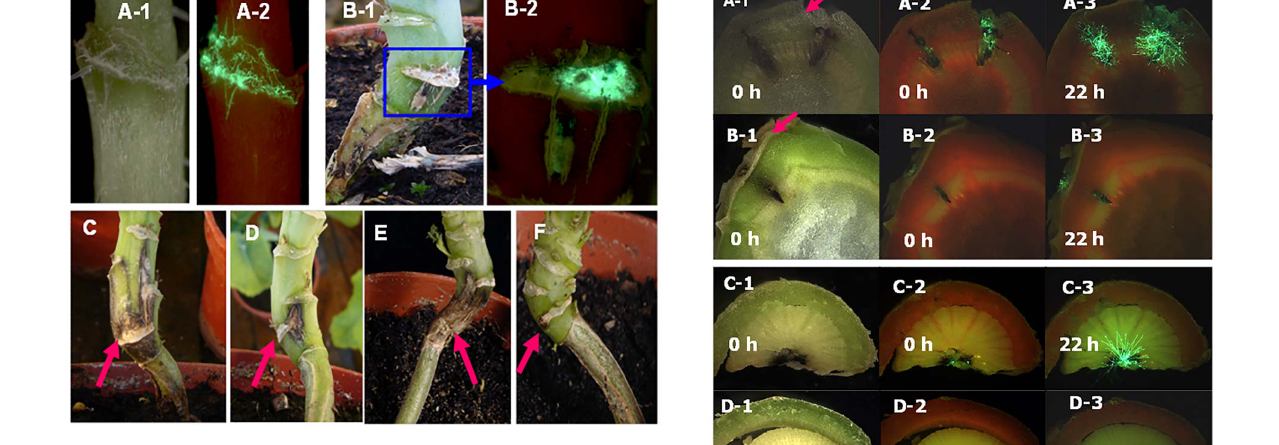
Figure 6. Phoma stem canker symptoms produced in con- trolled conditions. Leaf petioles of oilseed rape doubled haploid lines A30 (susceptible) or C119 (with quantitative resistance) were inoculated with conidia of GFP-expressing Leptosphaeria maculans isolate ME24/ 3.13 (A, B, C) or ascospores produced on stem debris under natural conditions (E, F). No visible stem canker symptom at the leaf scar (A-1) of A30 after the inoculated leaf had abscised at 25 days post inoculation (dpi) but growth of the pathogen was observed using a GFP2 filter (A-2). Stem canker was visible at the leaf scar of A30 at 36 dpi (B-1) and growth of L. maculans was visualised by GFP fluorescence (B-2) (the selected region in B-1 was viewed using a GFP2 filter). Symptoms at leaf scars of A30 (C, E) or C119 (D, F) at 87 dpi with conidia (C, D) or at 31 dpi with ascospores (E, F) (arrows indicate the leaf scars of inoculated leaves).